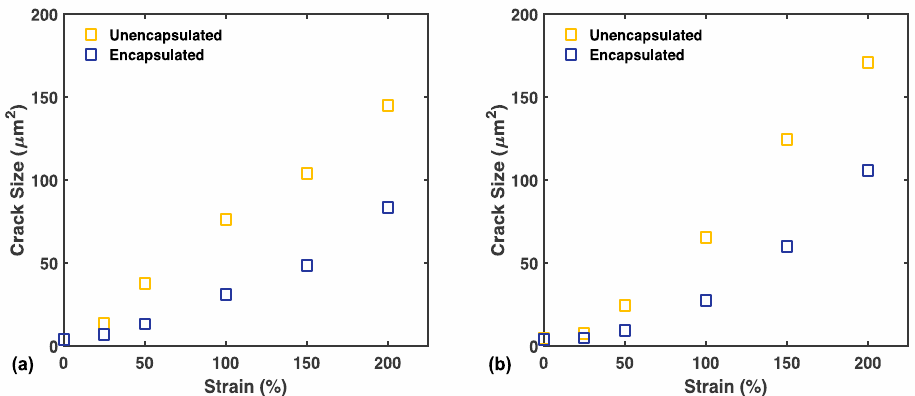
Figure 7. ( a ) Pre-fracture average crack area for unencapsulated and encapsulated sensors, N = 3 each. ( b ) Post-fracture average crack area for unencapsulated and encapsulated sensors, N = 3 each.